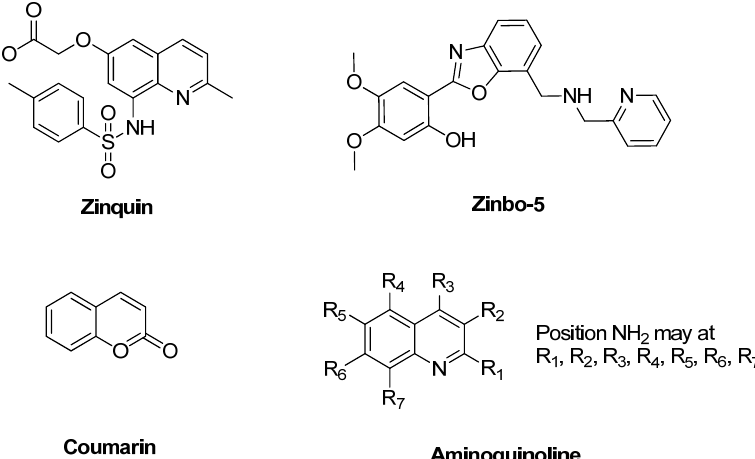
Figure 2. Structure of the earliest probe for zinc detection (Zinquin, Zinbo-5, coumarin and aminoquinoline 8-amidoquinoline). Aminoquinoline as a Fluorophore for Zinc’s Recognition